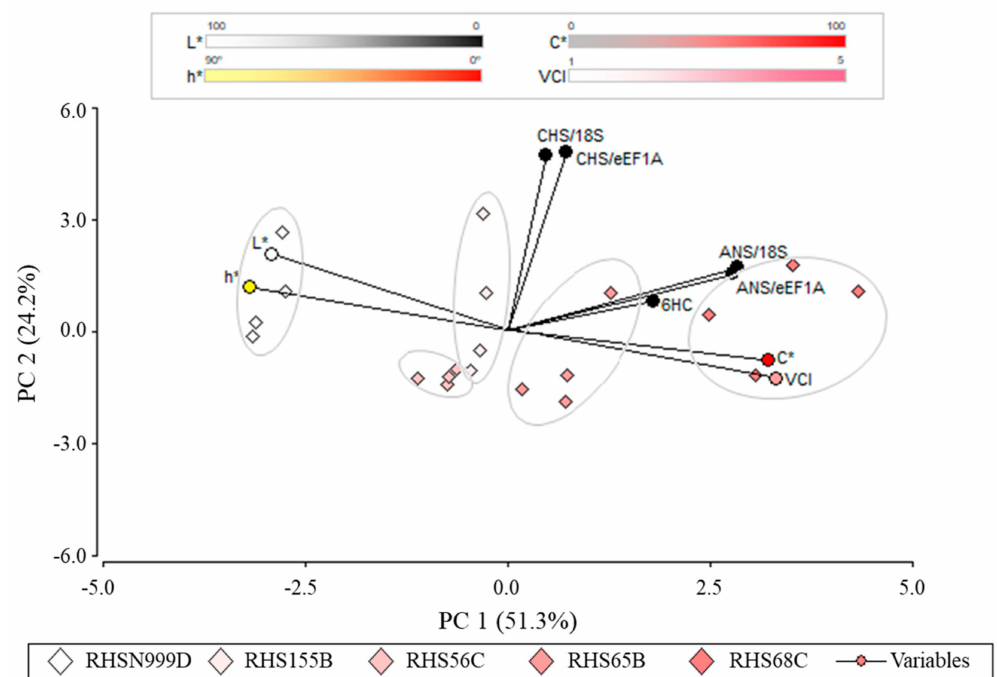
Figure 4. Biplot analysis of the principal components of the variables L*, C*, h*, VCI, 6-hydroxycyanidin relative concen- tration, CHS and ANS relative expression and the 5 A. pallida accessions de A. pallida . PC1: Principal component 1. PC2: Principal component